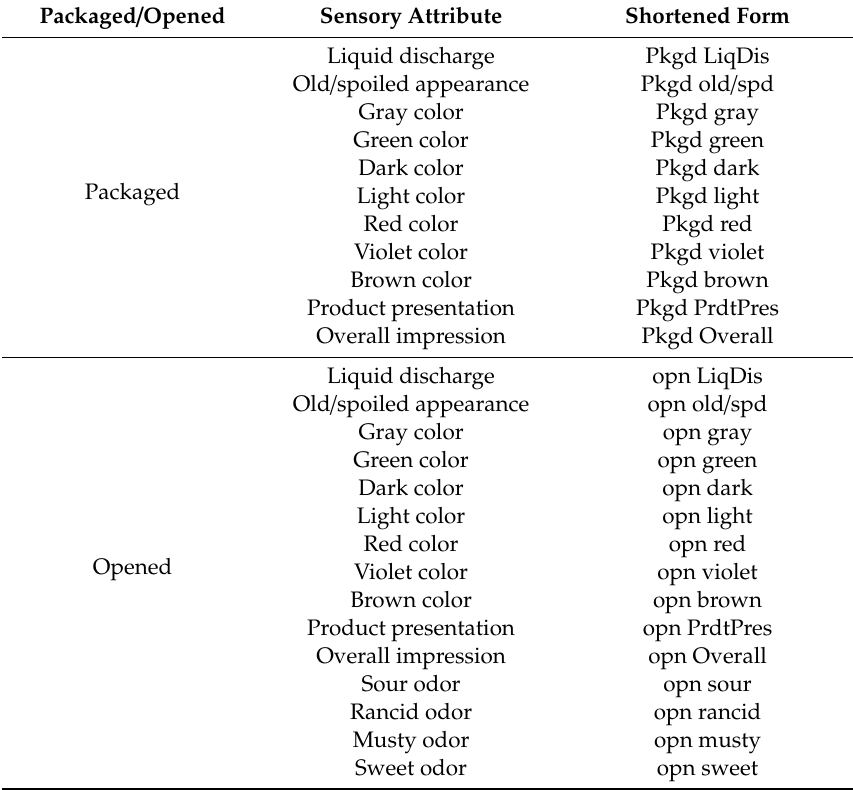
Table A1. Shortened sensory attributes used in the graphical representations of sensory evaluations in GM and